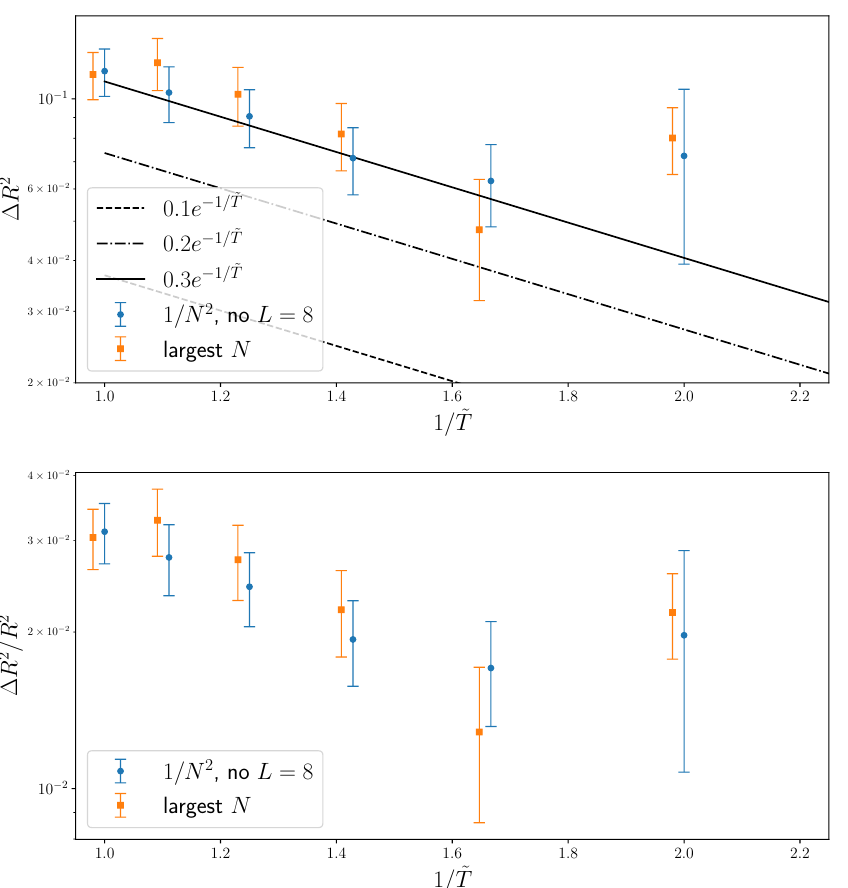
Figure 7. [Upper] (cid:1) ~ R 2 as functions of 1 = ~ T together with some representative functional forms to guide the eye (as done for (cid:1) ~ F 2 , but with ten times smaller coe(cid:14)cients). The datasets shown are in the large- N continuum limit or at our largest N value. [Lower] (cid:1) ~ R 2 = (cid:22) R 2 as functions of 1 = ~ T , where (cid:22) R 2 is the average value between the ungauged and the gauged theory. There is a clear decreasing trend as the temperature decreases, but the statistical uncertainties become too large at the smallest temperatures to say anything conclusive about the ~ T = 0